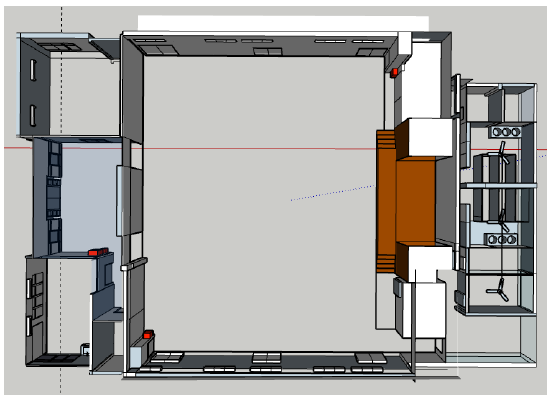
Figure 4. The indoor model of building.